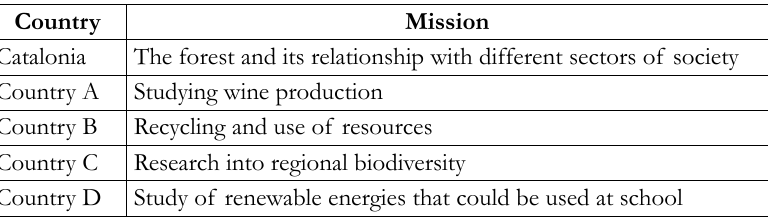
Table 1. Relationship between countries and